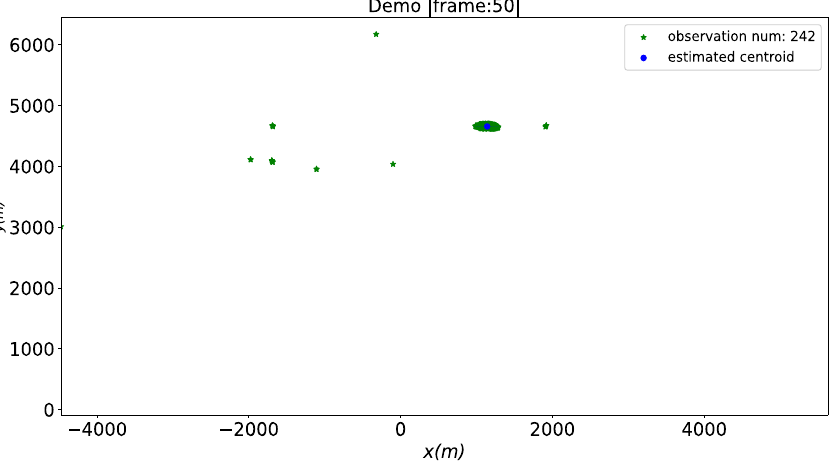
Figure 11. Single target in the Cartesian coordinate system tracking in the 50th frame.